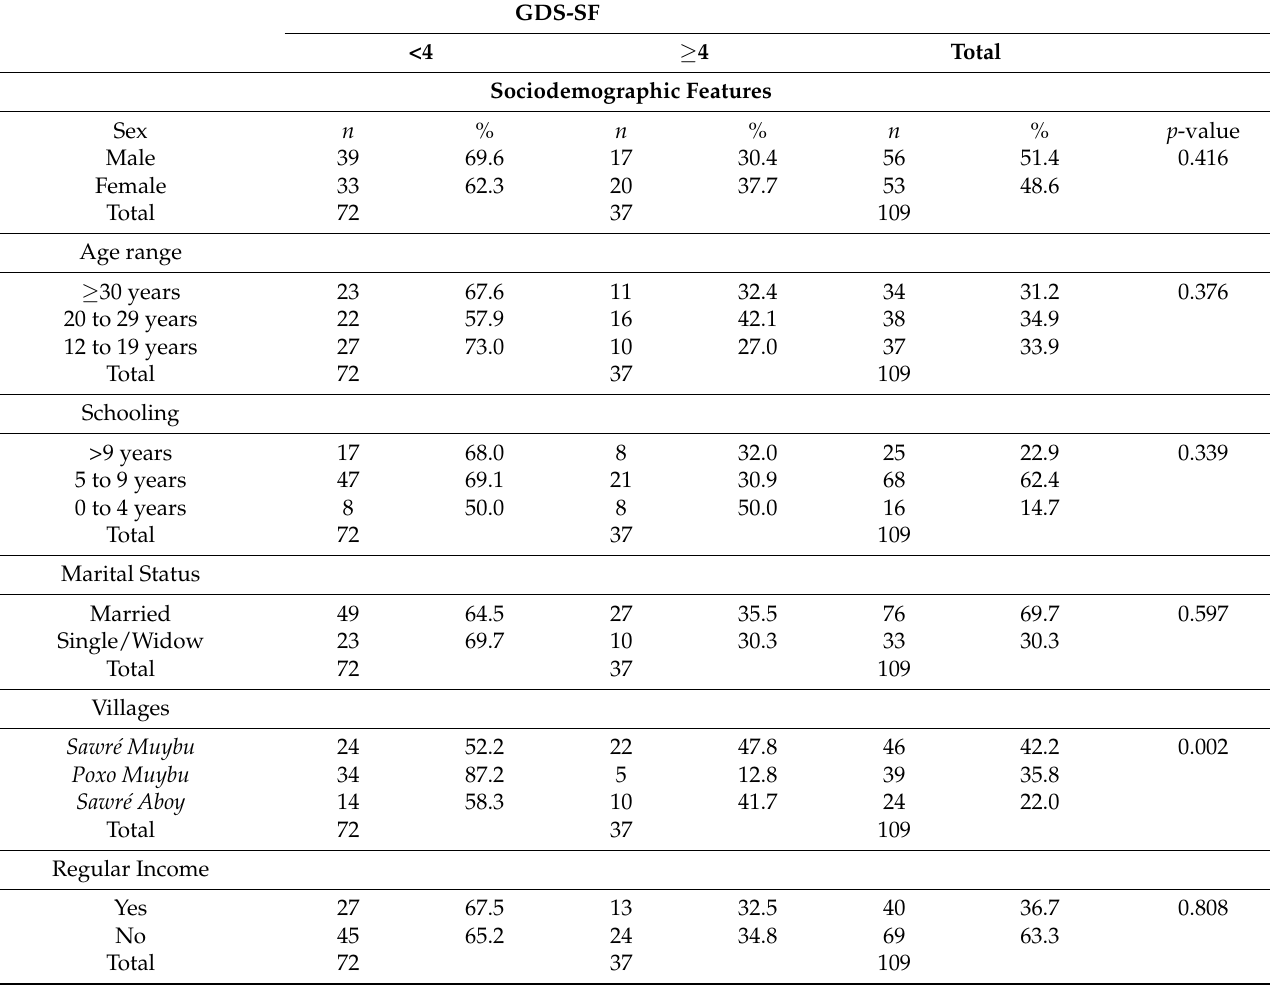
Table 1. Sociodemographic and clinical variables of the study participants, according to GDS-SF. Sawr é Muybu Indigenous Land, Par á , Brazilian Amazon,